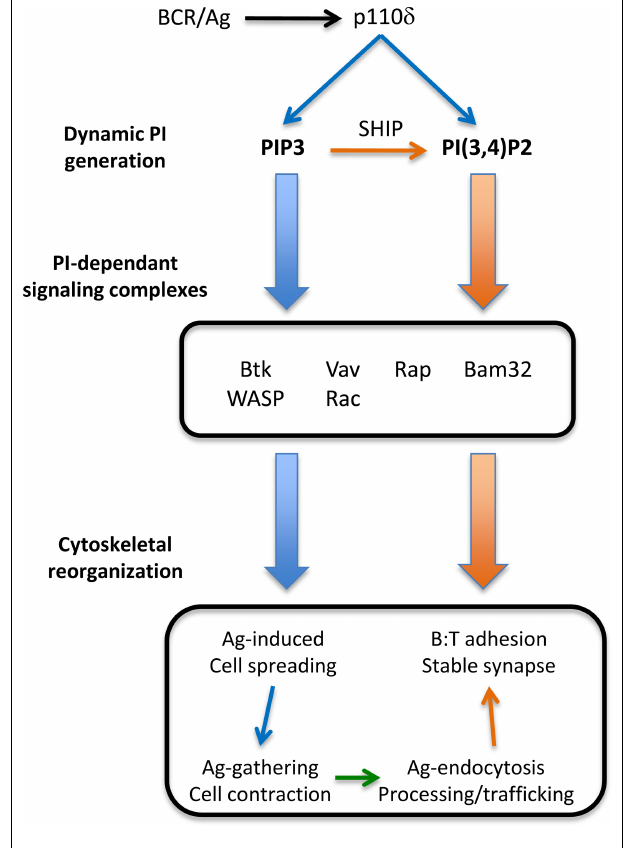
FIGURE 2 | Role of the PI3K pathway in B cell antigen presentation functions. The Figure outlines the D3 phosphoinositides and PI-dependant signaling complexes implicated in cytoskeletal reorganization associated with B cell Ag uptake and presentation.The involvement of different components in different steps of Ag presentation is discussed in the